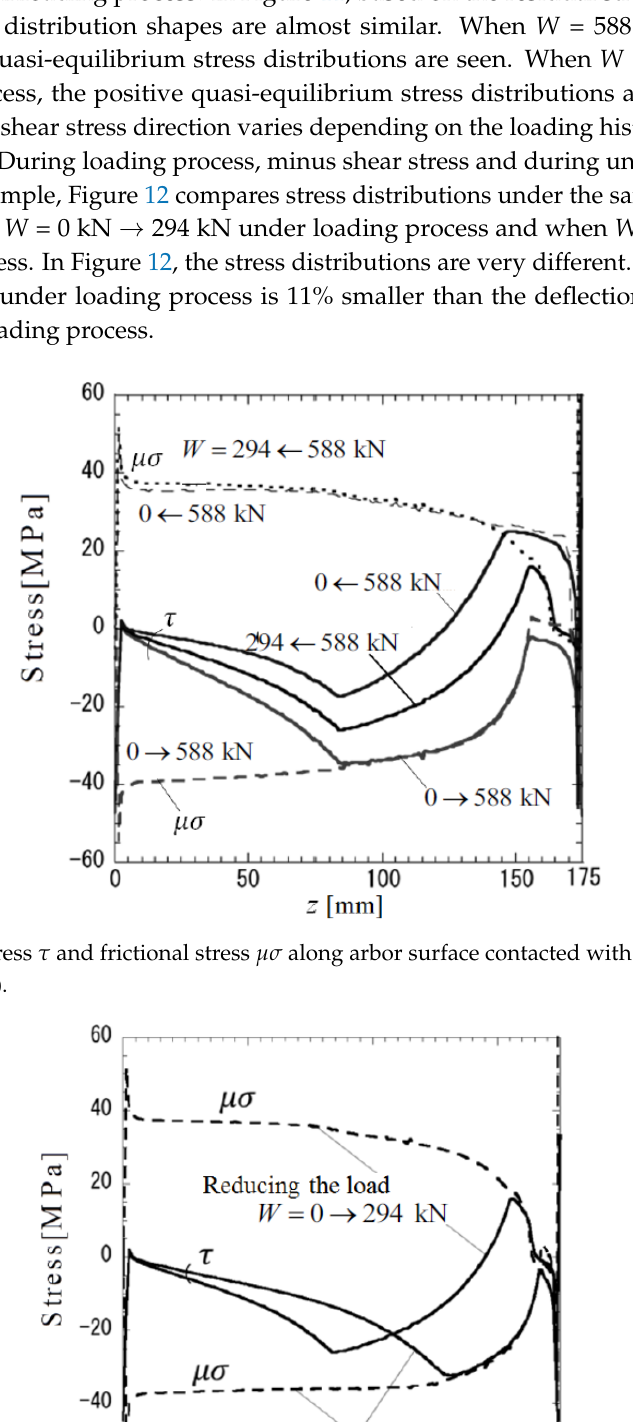
Figure 12. Shear stress τ and frictional stress µσ along arbor surface contacted with sleeve when W = 0 → 294 kN and W = 294 ← 588 kN ( µ = 0.5).